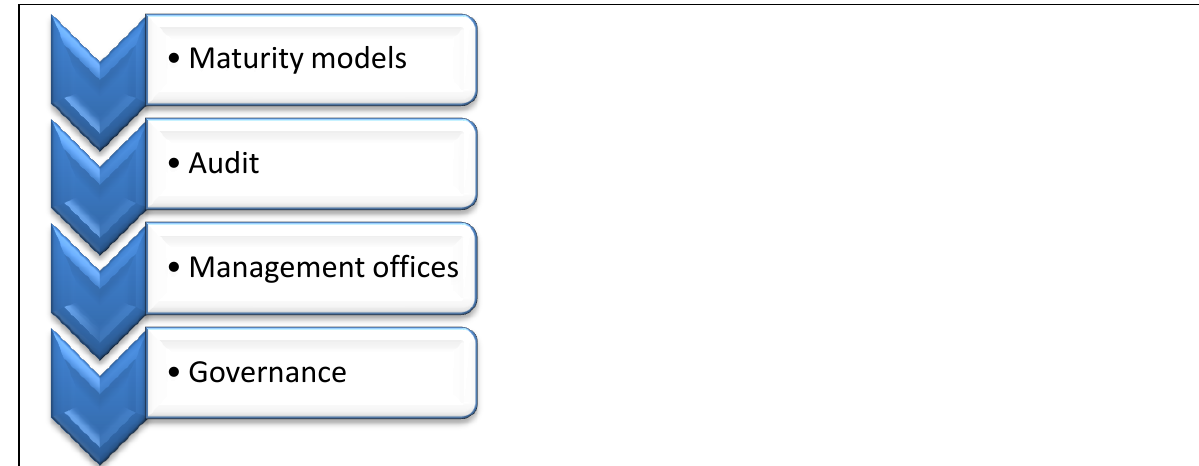
Figure 3. Components of organisational